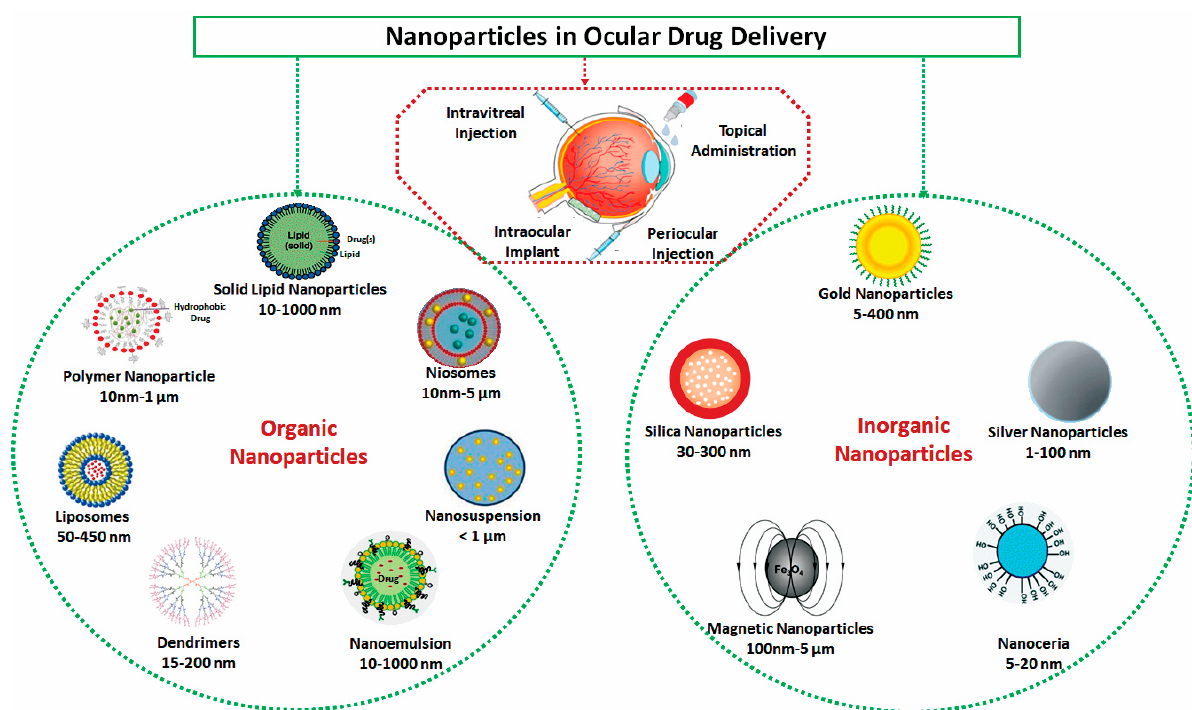
Figure 1. Schematic drawings for potential organic and inorganic nanoparticles for ophthalmic drug delivery.